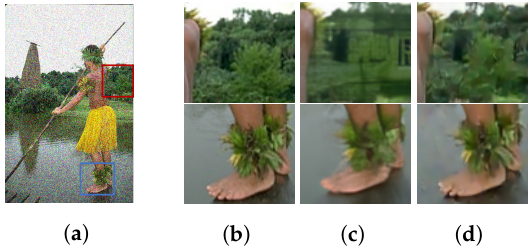
Figure 1. Demonstration of our contribution. An image from the BSD68 dataset with additive white gaussian noise (AWGN) noise with σ = 50. Here, the first column shows the ground truth, followed by the inference from the DEAMNet [8], and the final column shows the proposed result. From a side-by-side comparison, the proposed method can restore the image without the hallucination effects of deeper networks. ( a ) Noisy. ( b ) Ground Truth. ( c ) DEAMNet [8]. ( d )